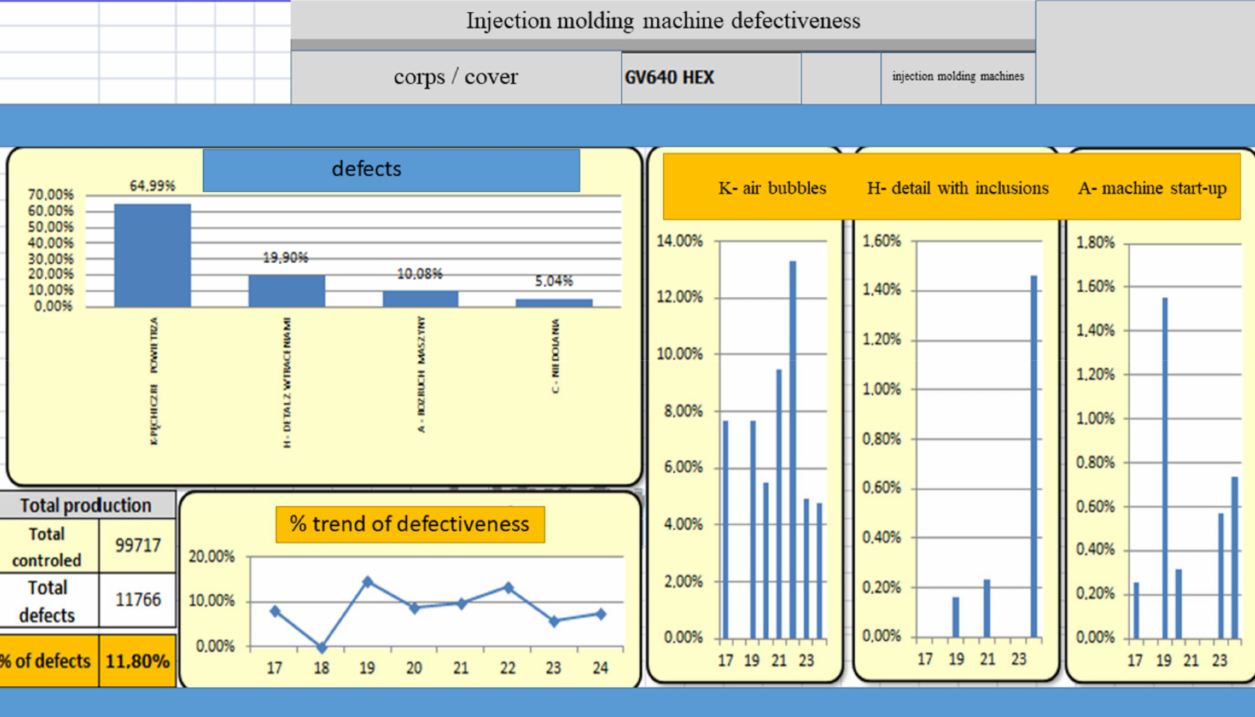
Figure 23. Defect analysis